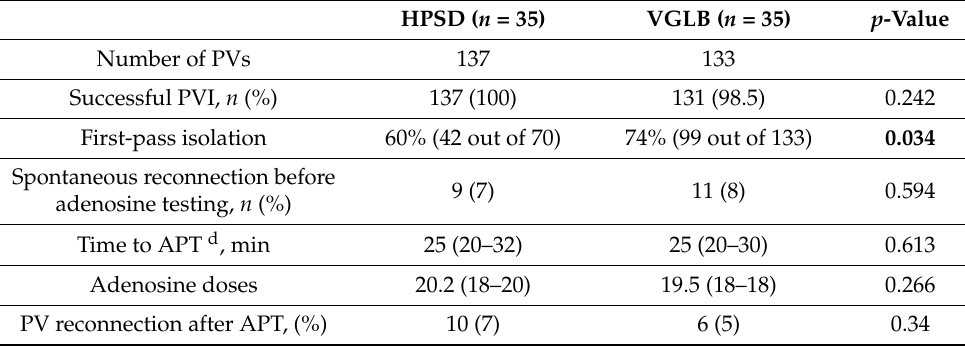
Table 4. Isolation and